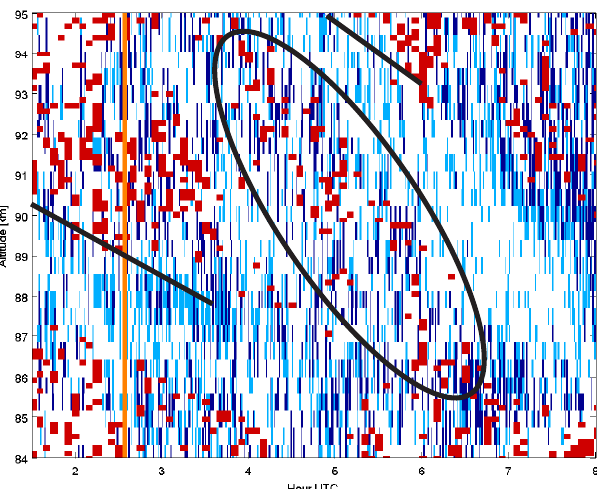
Fig. 7. Stability analysis from ALOMAR Na-lidar measurements of winds and temperature for 19 December 2010. The colour red rep- resents regions that are convectively unstable ( N 2 < 0), dark blue points represent regions of dynamical instability (0 < Ri < 1 / 4), and the light blue areas are regions with Ri < 1. Orange vertical line marks time of the ECOMA09